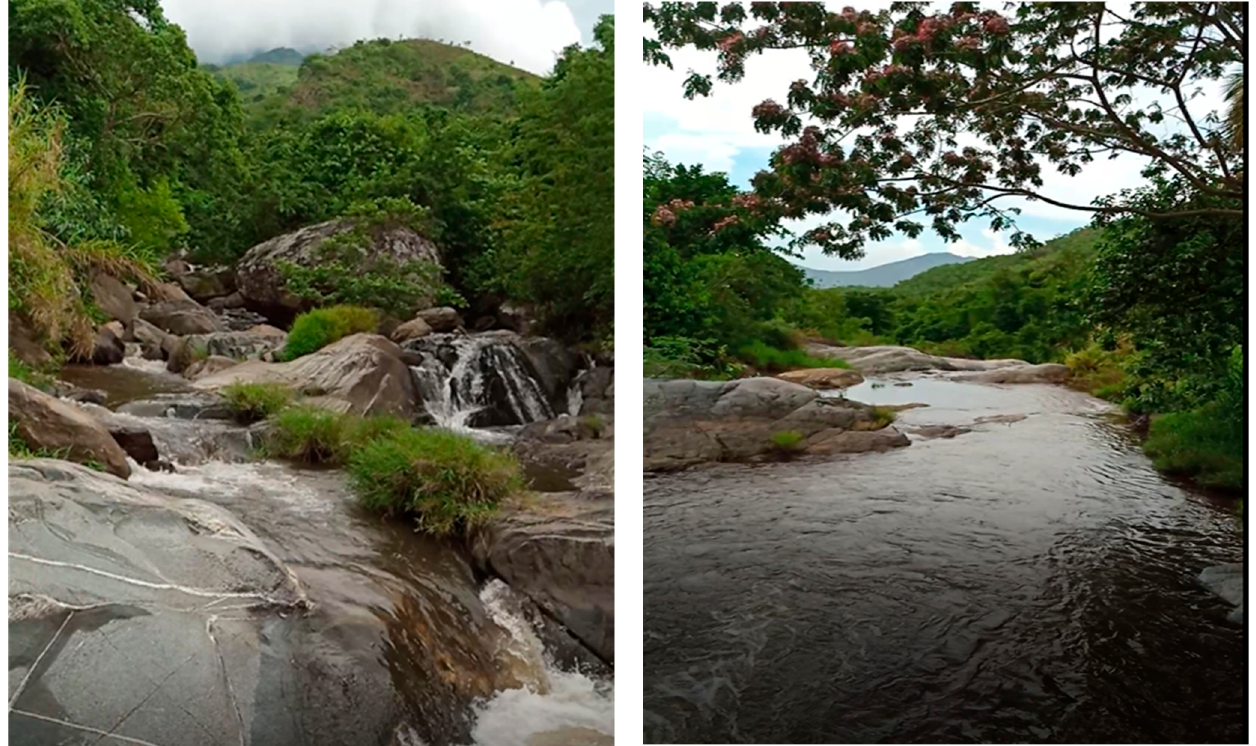
Figure A1. The upper part of the Ruvu sub-basin (the Uluguru Mountains).